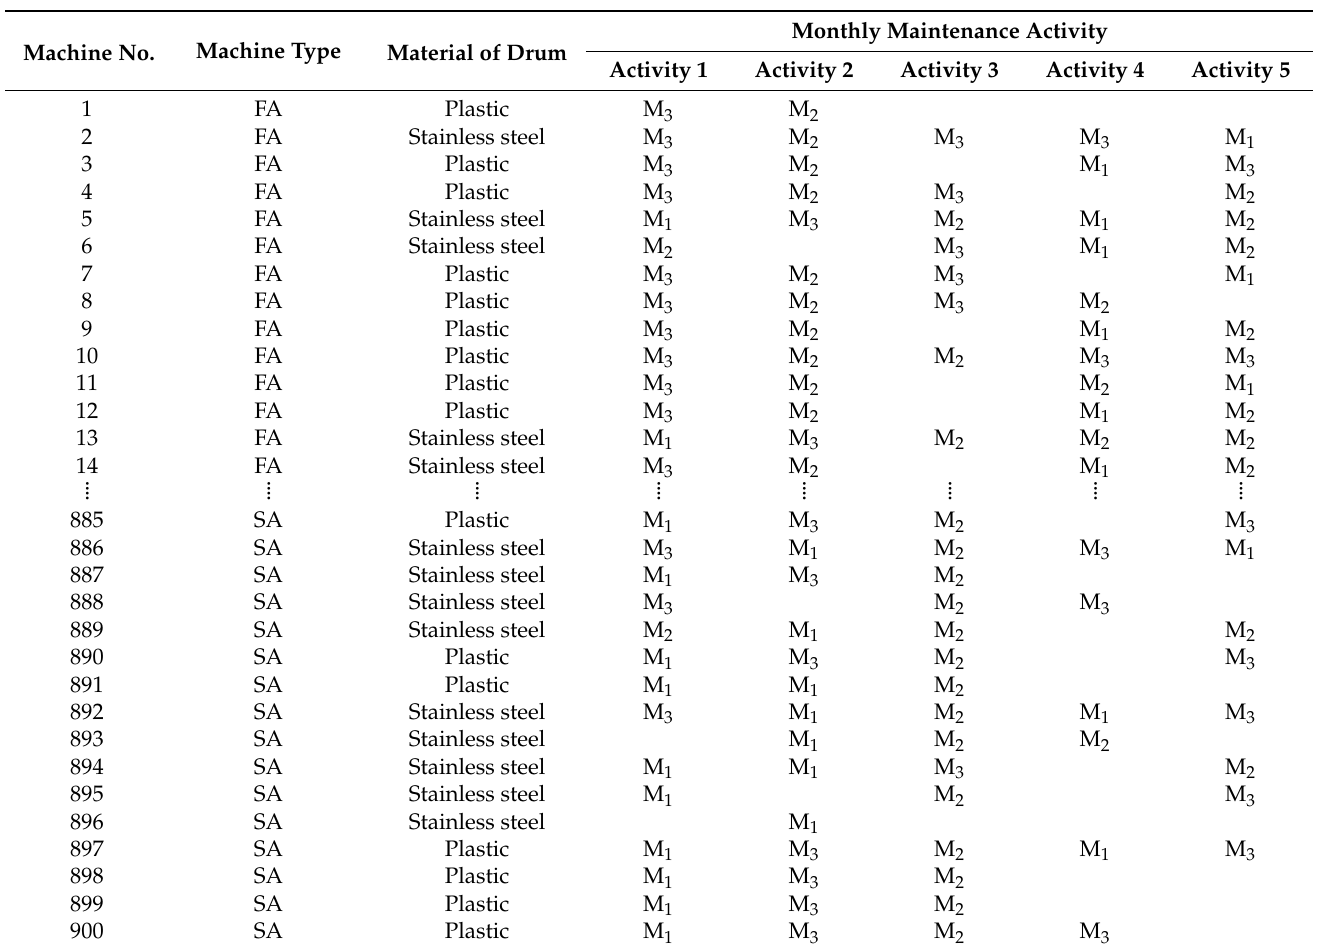
Table 6. Collected data for washing machine.